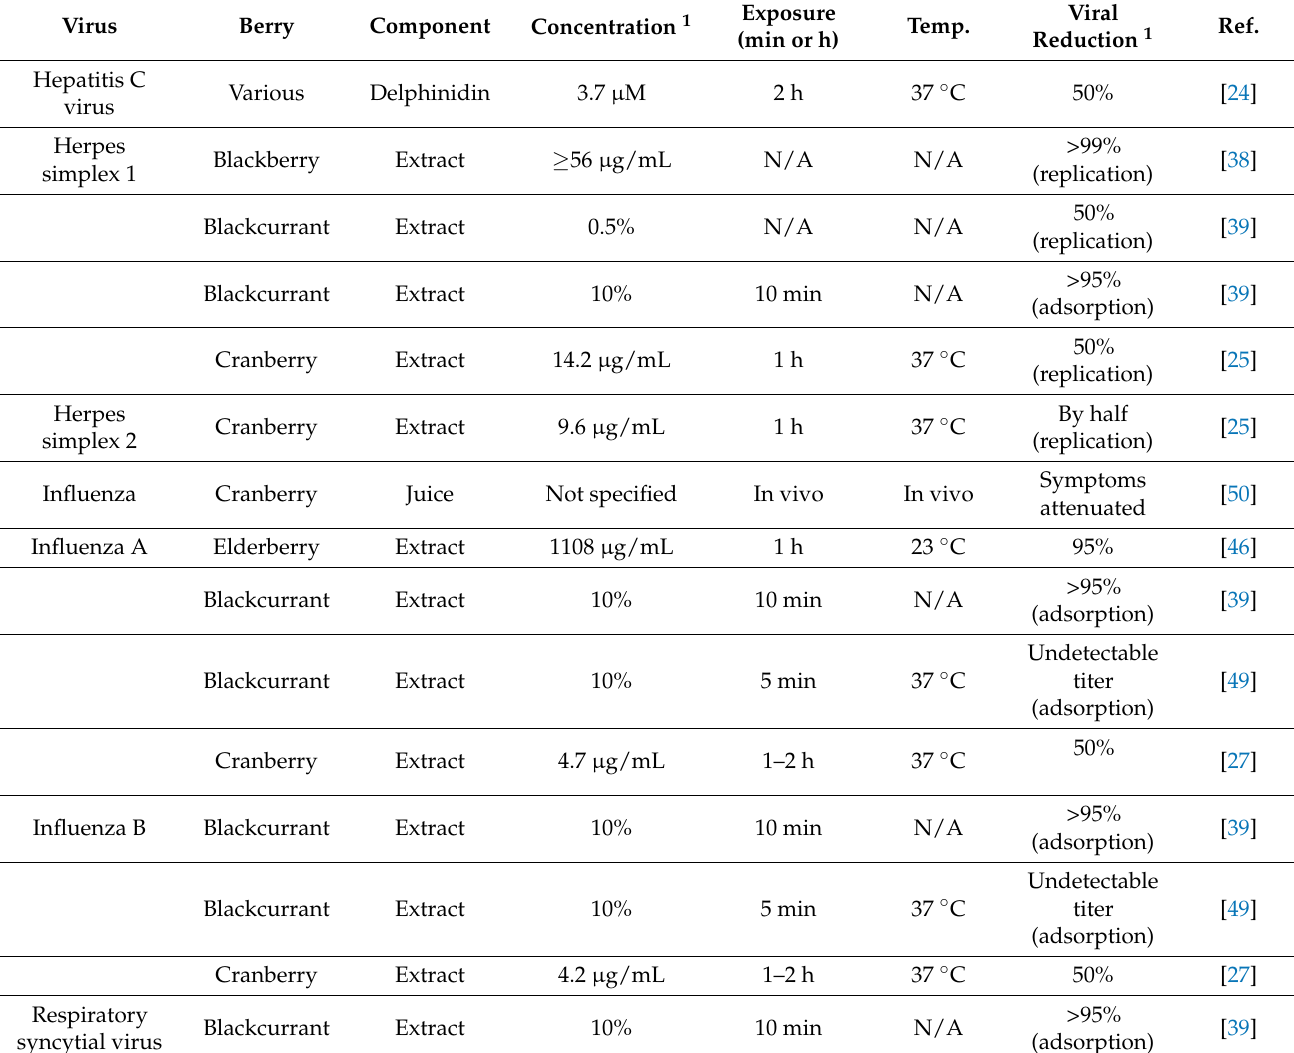
Table 1. Summary of reported antiviral effects of berries or constituents thereof on enveloped